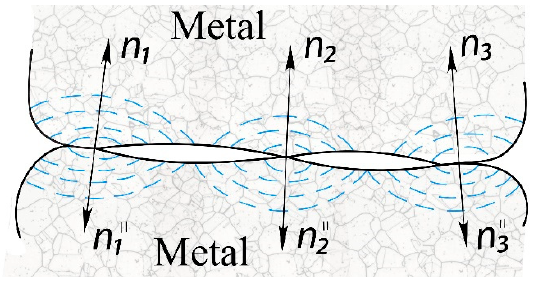
Figure 4. The contact of two rough surfaces.